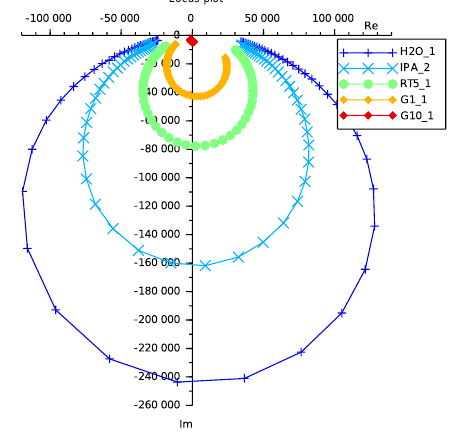
Figure 13. Corresponding Nyquist plot to Fig. 12.